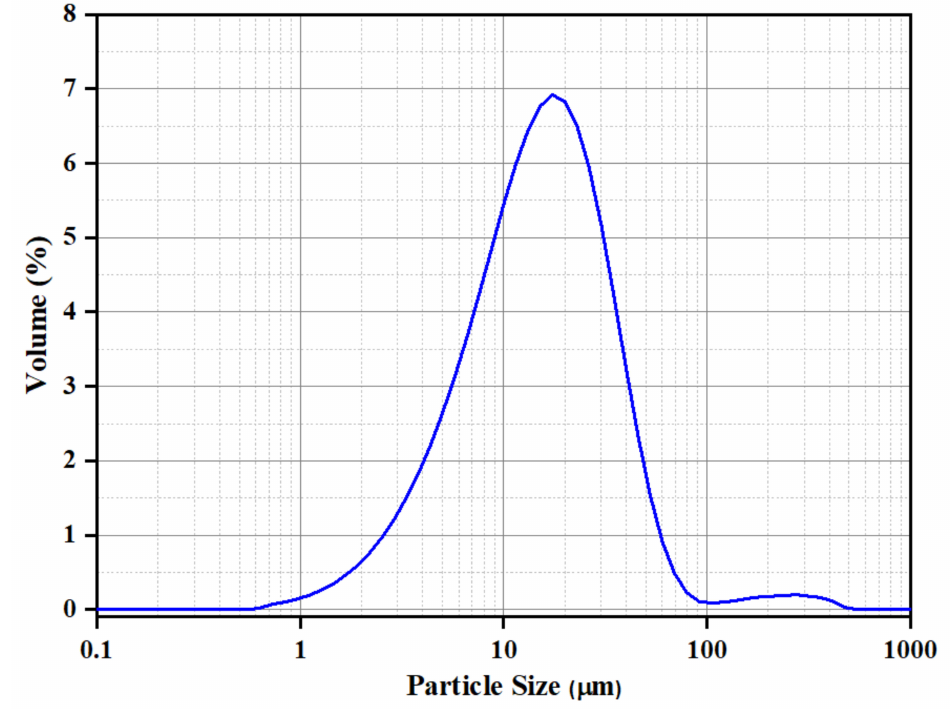
Figure 1. Particle size distribution of aluminium powders (Nanografi, Germany).